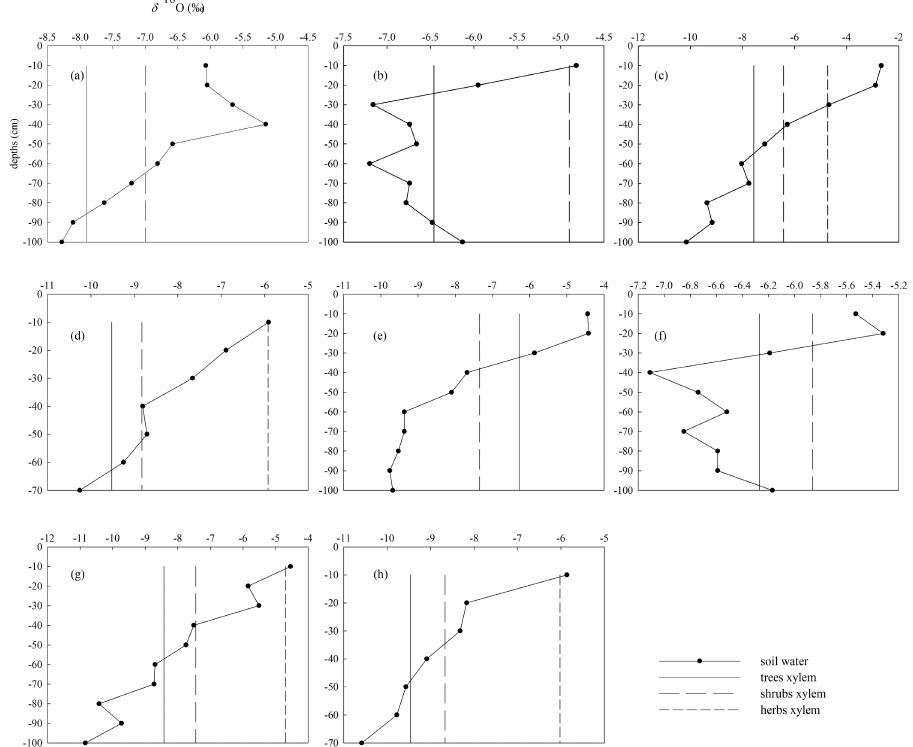
Figure 5. The relationships of δ 18 O among soil water and tree, shrub and herb xylem (( a – d ) represent Jiuzhoutai, Beishan, Northwest Normal University and Wetland Park in the dry season, respectively, while ( e – h ) represent Jiuzhoutai, Beishan, Northwest Normal University and Wetland Park in the wet season